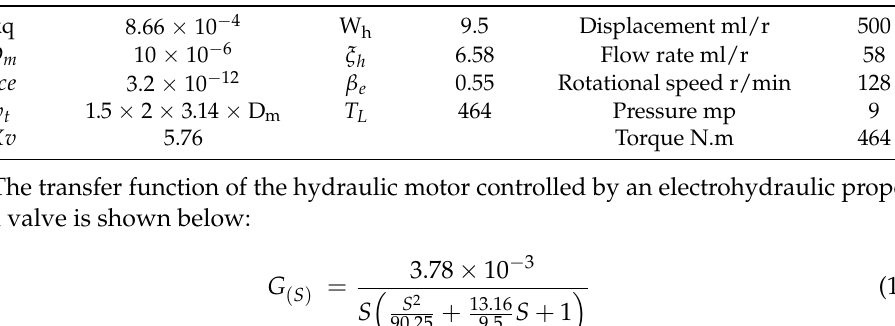
Table 4. Parameters of hydraulic motor and proportional solenoid valve.